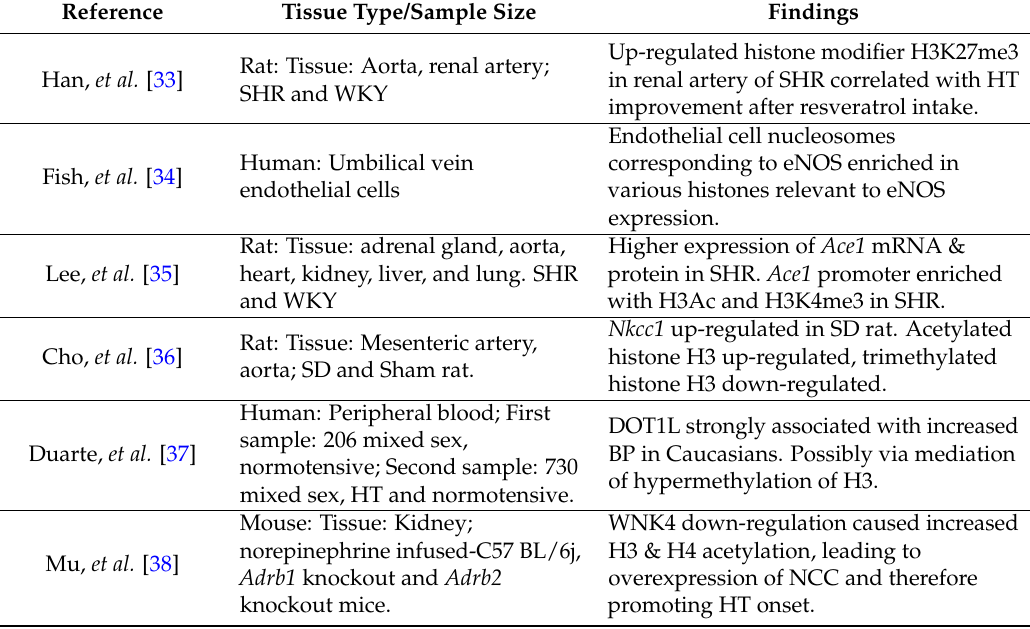
Table 2. Summary of histone modification findings in relation to